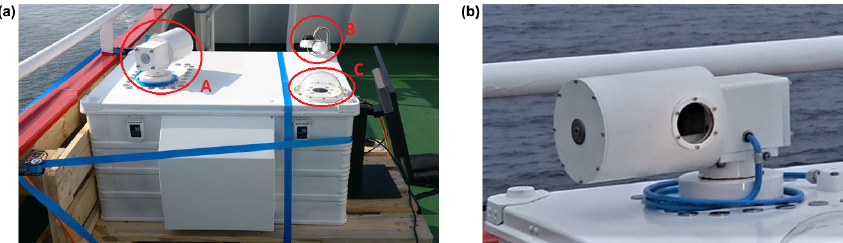
Figure 2. Photograph of the instrument container on board R/V Sonne (a) and the solar tracker housing (b) . The solar tracker housing (A in a ), the ambient sensors (B in a ), and the fisheye camera (C in a ) are mounted on top of the box. The solar tracker housing (b) consists of a cylinder which rotates around a horizontal axis in the elevation direction. The cylinder is mounted on a cube which is able to rotate around a vertical axis in the azimuth direction. Sunlight enters the tracker through a fused silica wedged